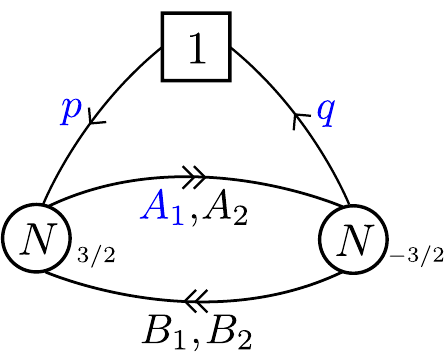
Figure 4 . Quiver diagram for the worldvolume theory of N M2-branes probing the cone over Y 1 , 2 ( P 2 ) . Coloured fields are present in an extra superpotential term, here ∆ W = pA 1 q , in addition to the standard ABJM